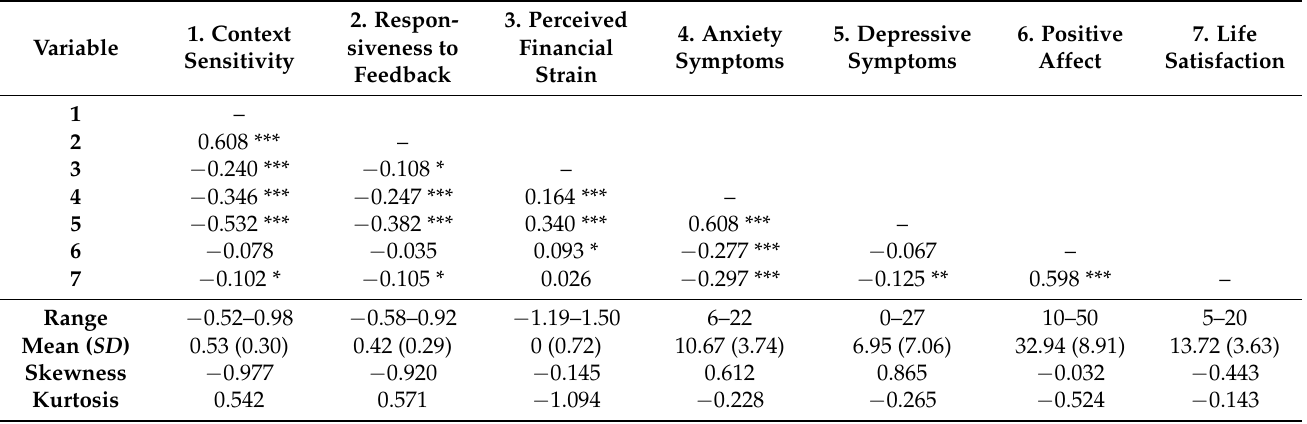
Table 4. Descriptive statistics and correlations of the study variables in Study